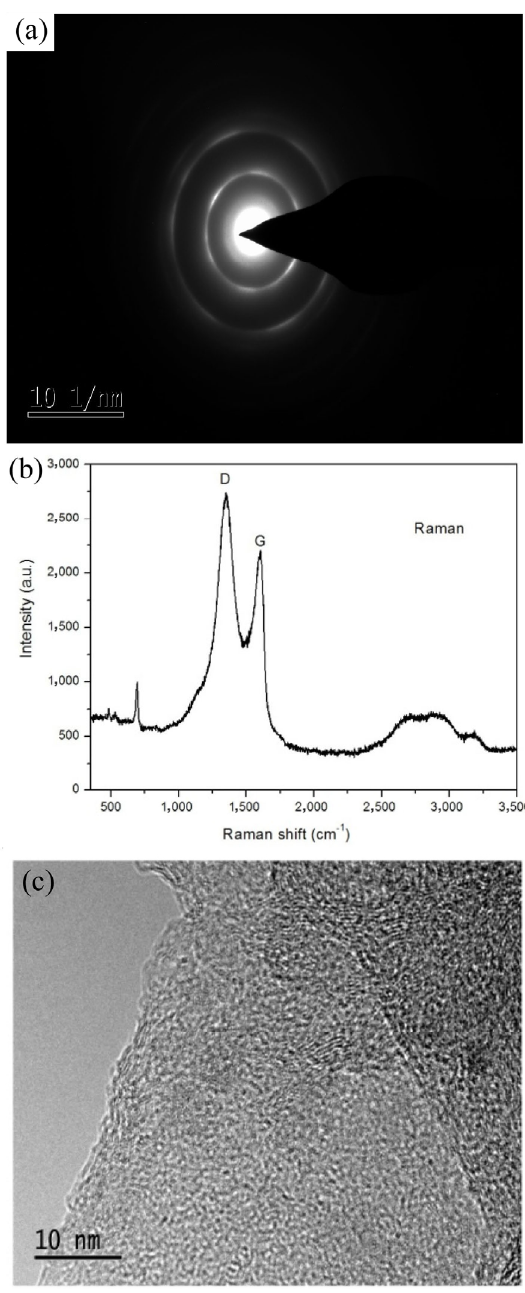
Fig. 5 Graphene microstructure and morphology in the coating cross section: (a) SAED analysis, (b) Raman spectroscopy analysis, and (c) TEM analysis.